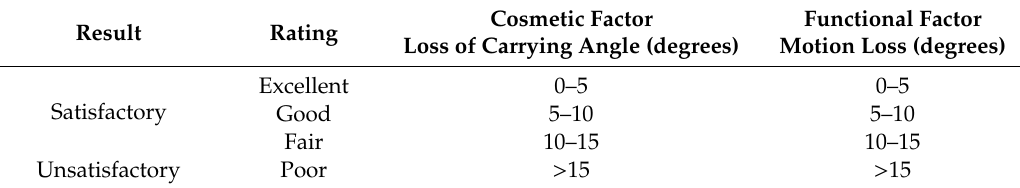
Table 2. Flynn criteria.